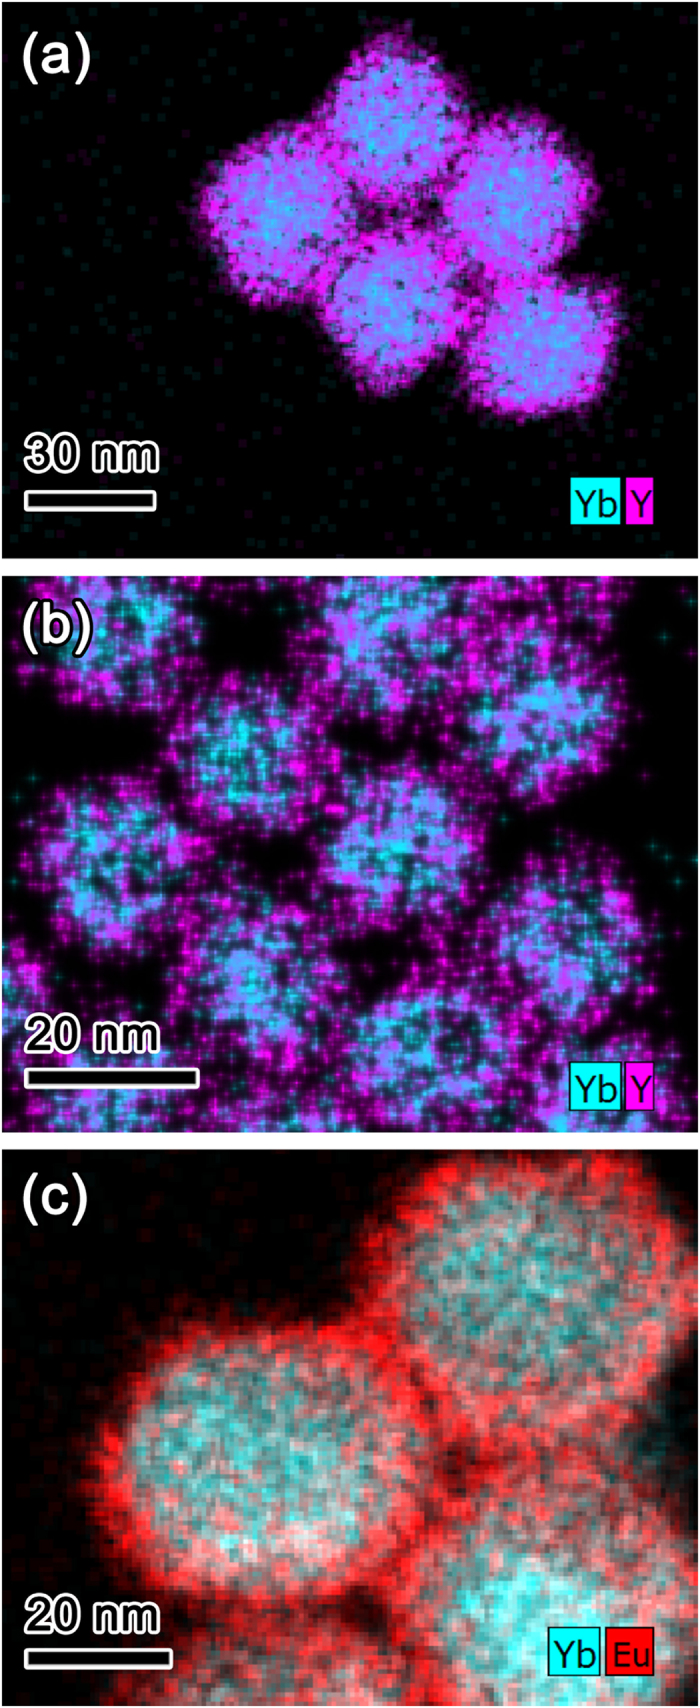
EDS maps superposed with Yb Lα (cyan) and Y Kα (magenta) for (a) Li(Gd,Y)F4:Yb,Er/LiYF4 UCNPs, (b) Li(Gd,Y)F4:Yb,Tm/LiYF4 UCNPs, and (c) EDS map superposed with Yb Lα (cyan) and Eu Lα (red) for NaGdF4:Yb,Tm/NaGdF4:Eu UCNPs.